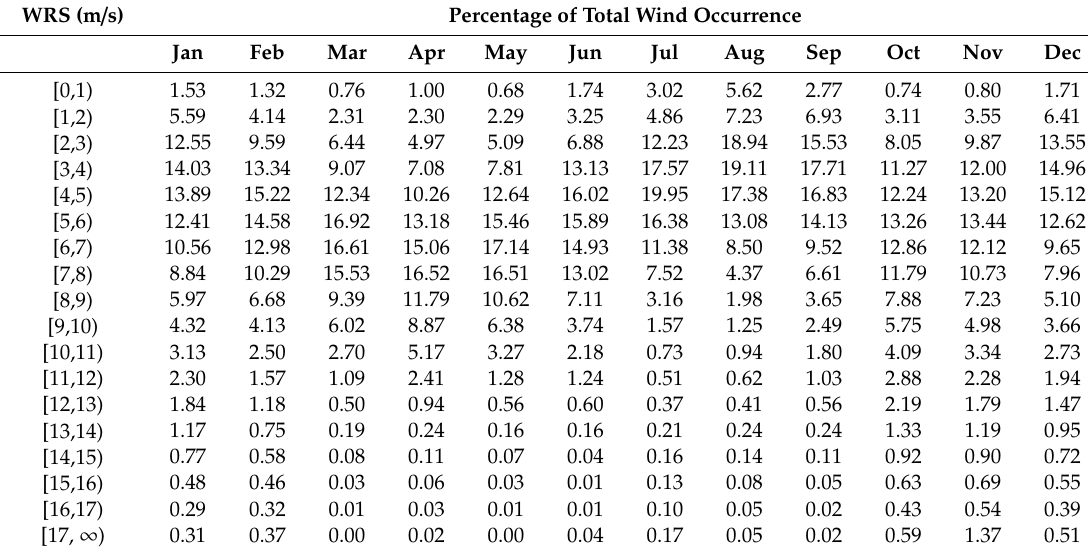
Table 3. Percentages of the monthly WSRs.